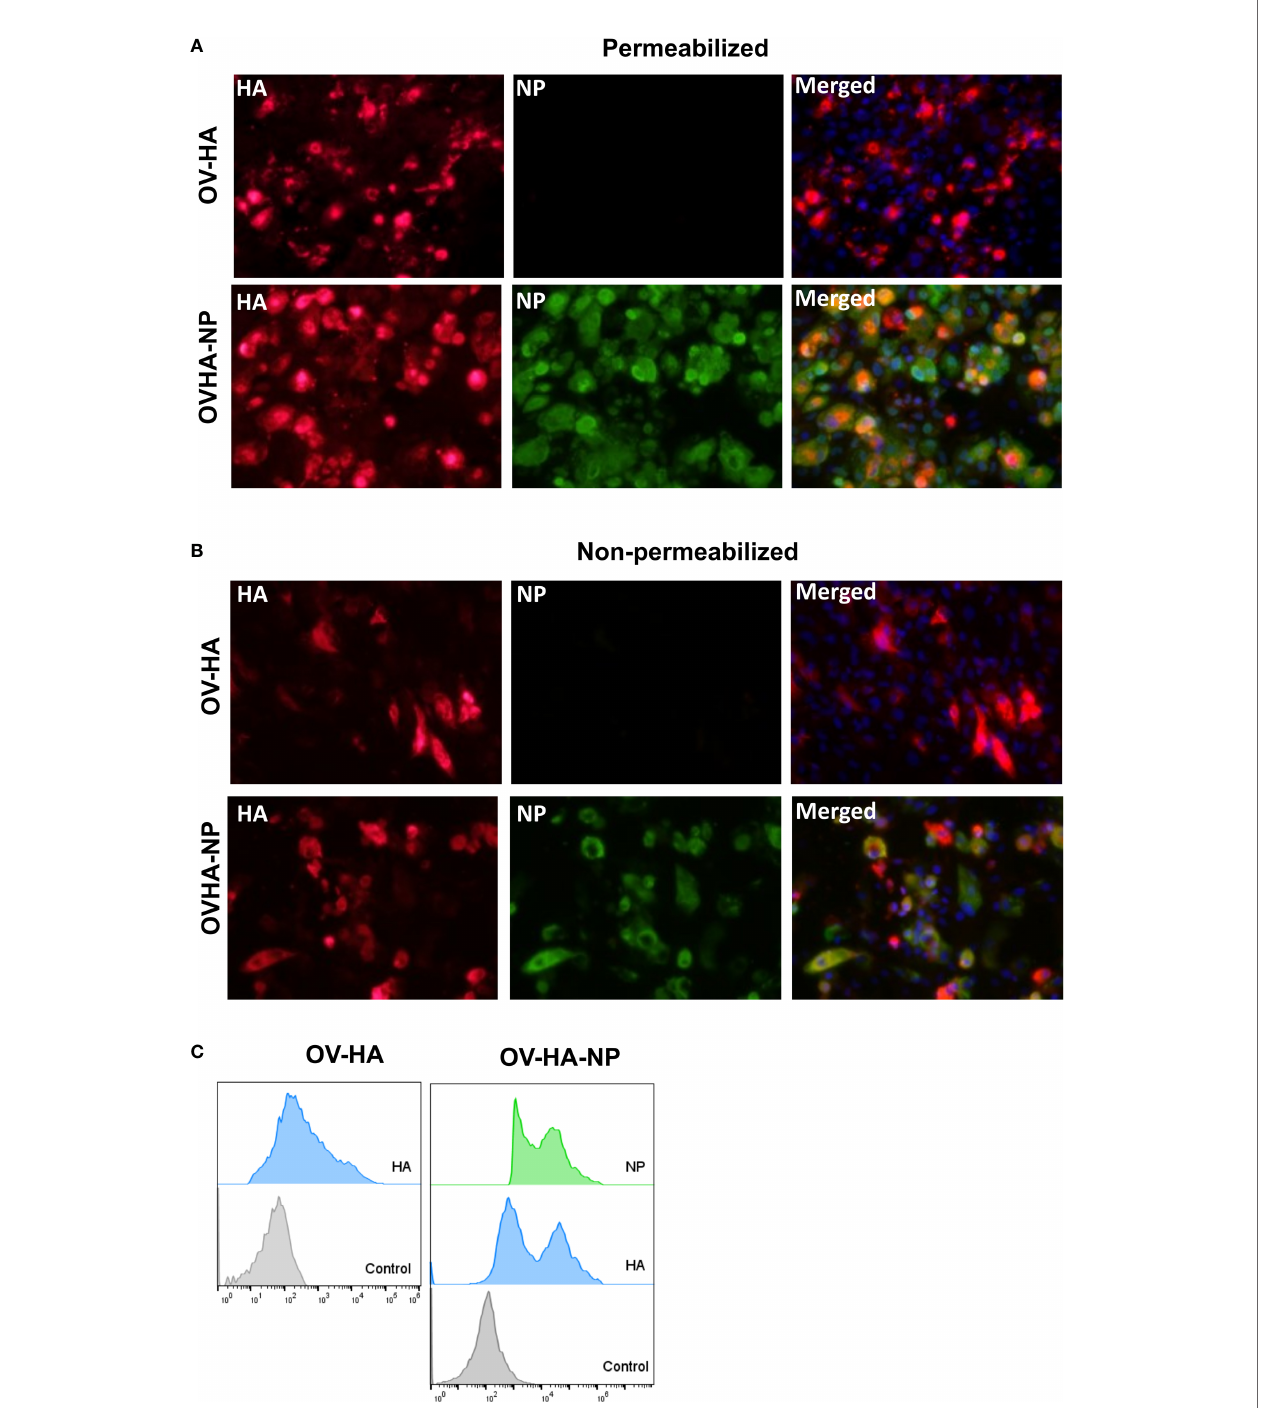
FIGURE 2 | Expression of heterologous proteins by ORFV recombinants. (A) Immuno fl uorescence assay in permeabilized OFTu cells. Upper panel shows expression of HA protein and absence of NP protein in OV-HA recombinant. Lower panel shows expression of HA and NP protein by OV-HA-NP recombinant. (B) Immuno fl uorescence assay performed in non-permeabilized OFTu cells. Upper panel shows expression of HA by OV-HA recombinant and lower panel shows expression of HA and NP by OV-HA-NP recombinant. Blue fl uorescence in merged images in panel A and B indicates nuclear staining by DAPI. (C) Expression of heterologous proteins by ORFV recombinants assessed by fl ow-cytometry. OFTu cells were infected with OV-HA, OV-HA-NP or Wild-type OV-IA82 as negative control. Infected cells were collected 48 hours post-infection, fi xed and then stained with appropriate antibodies for fl ow cytometric